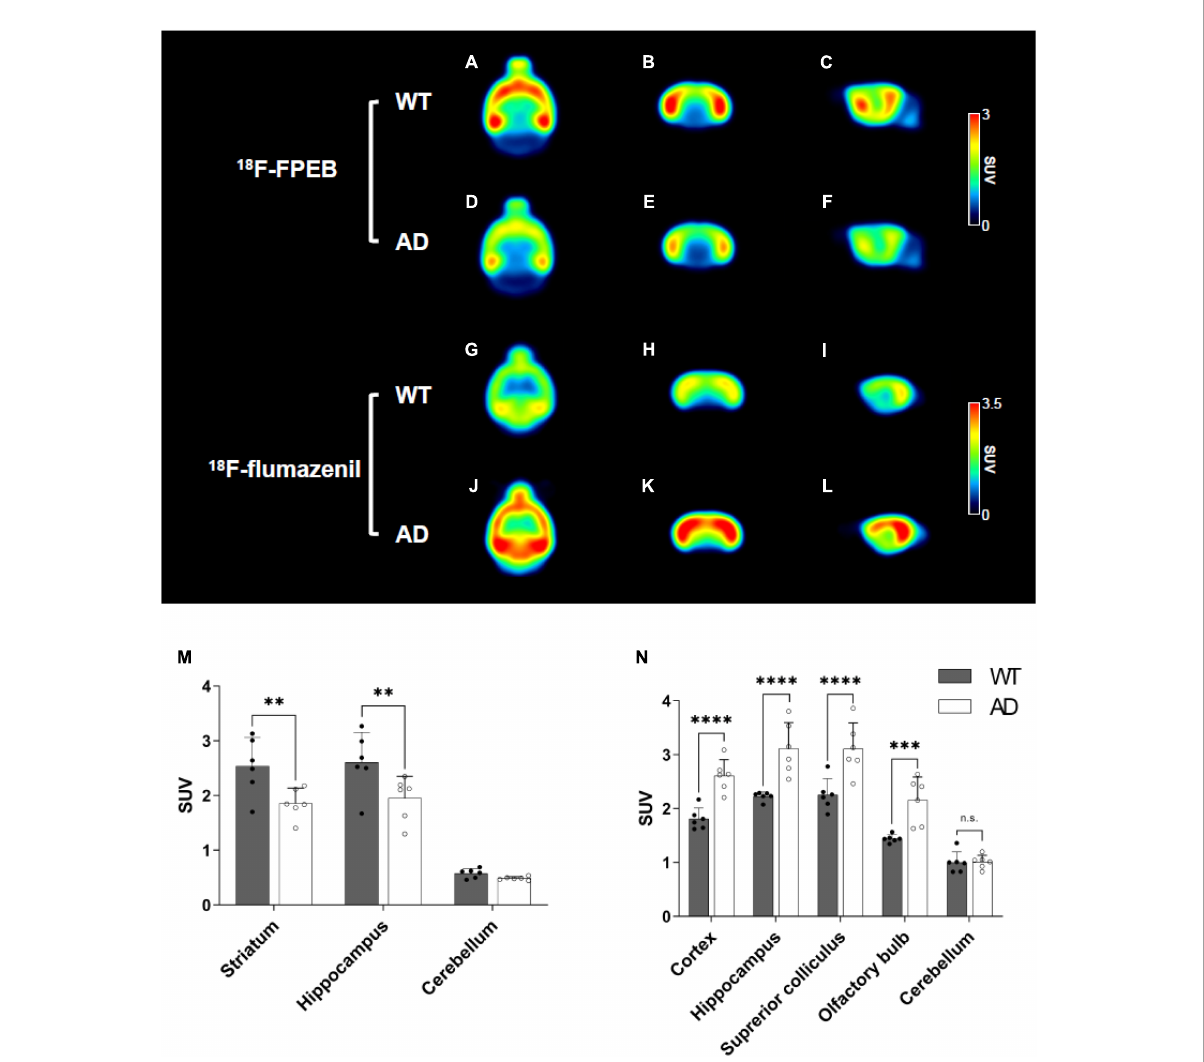
FIGURE4 Mean positron emission tomography (PET) images of 18 F-FPEB [wild-type (WT) (A–C) and Alzheimer’s disease (AD) (D–F) at 40–60 min] and 18 F-flumazenil [WT (G–I) and AD (J–L) at 30–50 min]. Quantification of the radioactivities for the 18 F-FPEB (M) and 18 F-flumazenil (N) . Data are presented as the mean ± SD ( n = 6). Statistical significance was defined as a p value less than 0.05 for comparisons between groups (** p < 0.01, *** p < 0.001, and **** p <